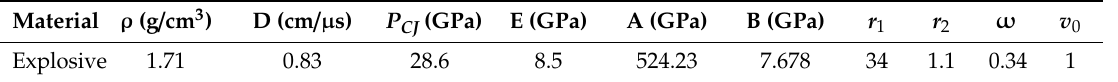
Table 2. Material parameters for 8701 explosive. Table 2. material parameters for 8701 explosive.